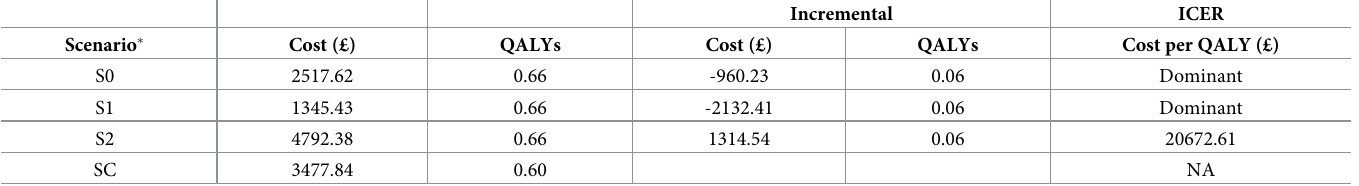
Table 6. Cost-effectiveness results for FlowOx ™ therapy (one dose per annum) compared to standard care over one-year.